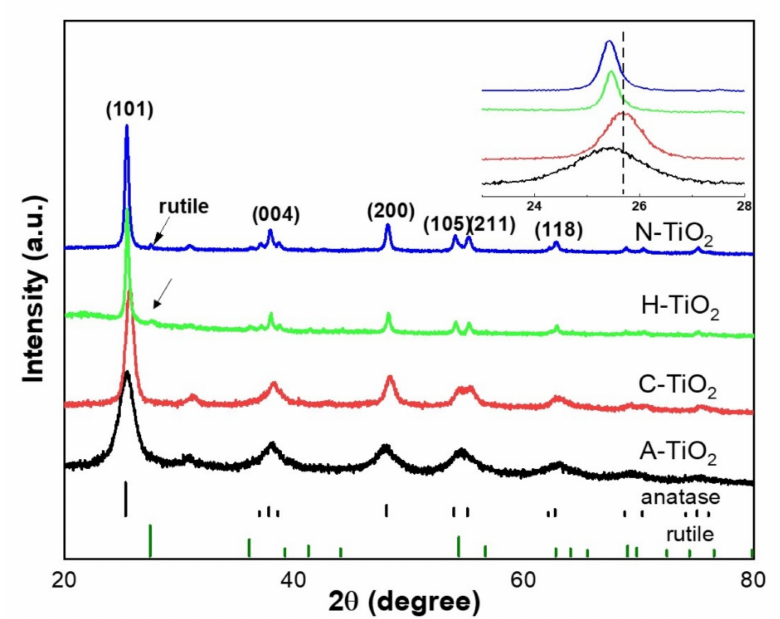
Figure 2. XRD patterns of the prepared TiO 2